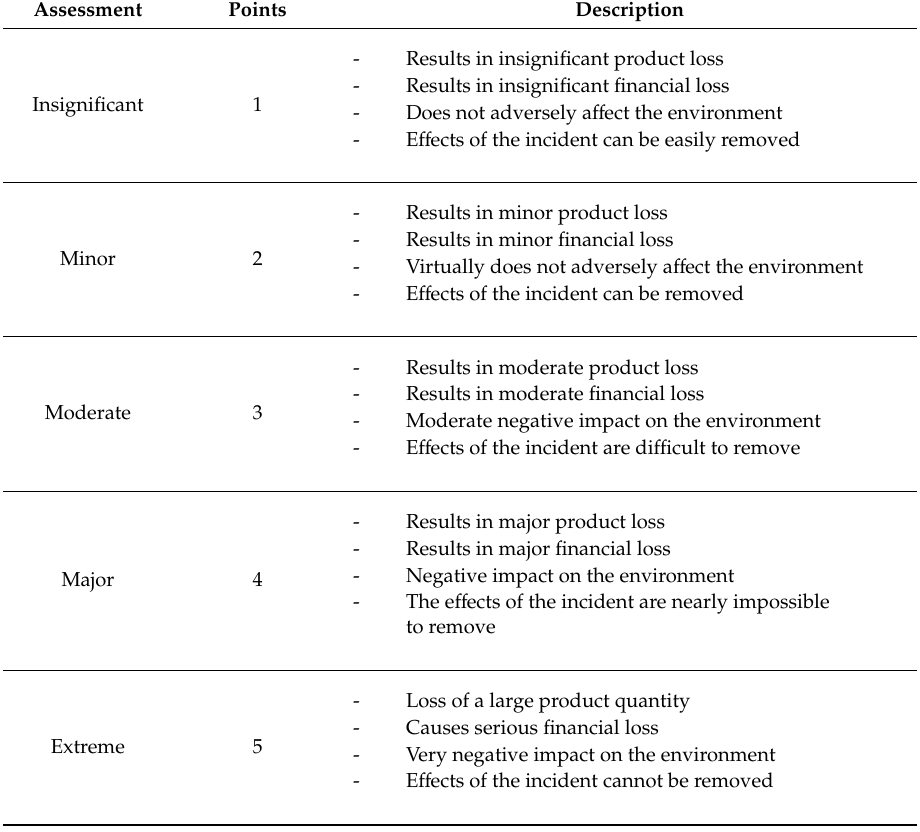
Table 3. Consequences